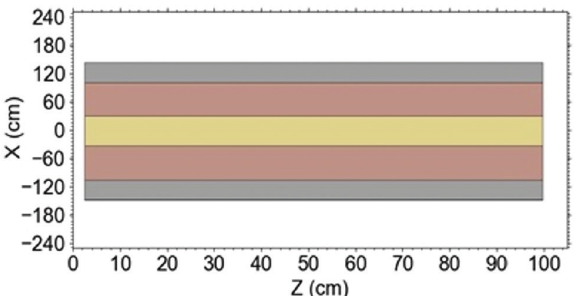
Figure 3. Computational 3D Model: longitudinal section of the model in the X-Z